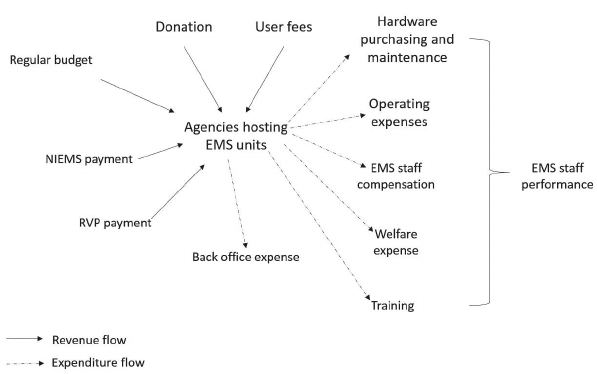
Figure3:Causalloopdiagramofpotentialexplanatorymechanisms of EMS overall